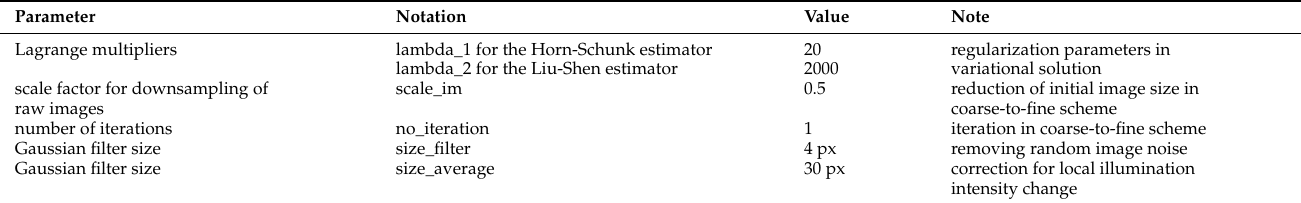
Table A1. Optical flow input parameters and